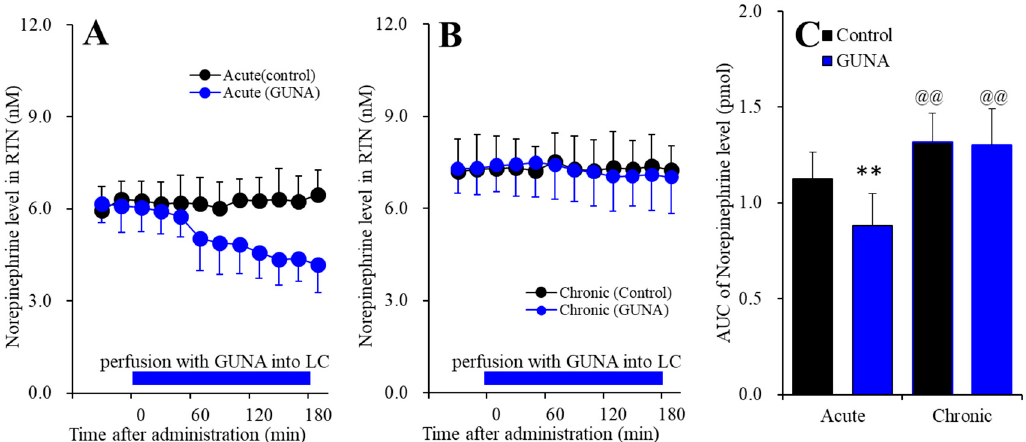
Figure 4. Effects of acutely local administration (perfusion with) 200 nM guanfacine into the LC on extracellular norepi- nephrine level in the RTN, after the systemically chronic administration of guanfacine (0 or 0.12 mg/kg/day for 14 days). Panel ( A ) indicates the effects of perfusion with 200 nM guanfacine into the LC after chronic administration of guanfacine (0 mg/kg/day) for 14 days (acute effects). Panel ( B ) indicates effects of 200 nM guanfacine after systemically chronic administration of guanfacine (0.12 mg/kg/day) for 14 days (chronic effects). Ordinates: mean ± SD (n = 6) of extracellular norepinephrine level (nM), abscissa: time after administration of perfusion with guanfacine into the LC (min). Blue bars: perfusion of 200 nM guanfacine into LC. Panel ( C ) indicates the AUC 20–180 min values of extracellular norepinephrine level during perfusion with guanfacine (from 20 to 180 min). Ordinates: mean ± SD (n = 6) of AUC 20–180 min values of extracellular norepinephrine level (pmol). Black and blue columns indicate respective control and perfusion of guanfacine of AUC values of norepinephrine levels. When the effects of guanfacine were statistically significant compared using MANOVA, the data were analysed using Tukey’s post hoc test. ** p < 0.01, compared with control. @@ p < 0.01: compared with acute effects of guanfacine.